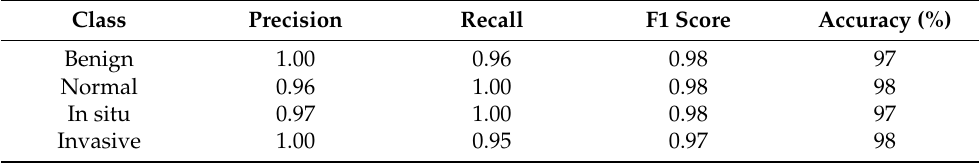
Table 5. Image-level classification results in terms of precision, recall, F1 score, and accuracy.